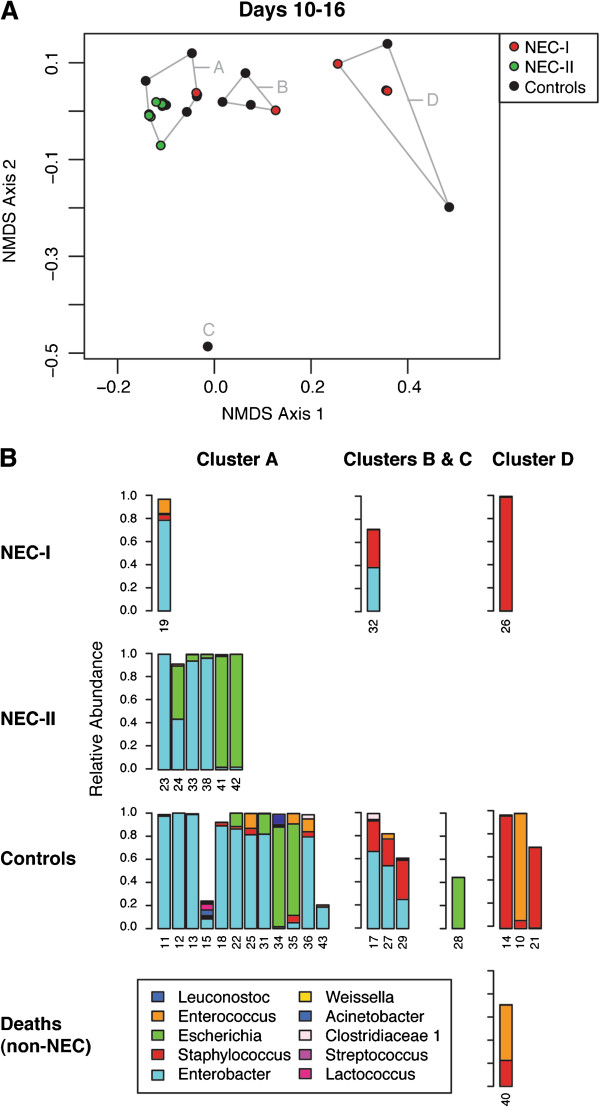
NMDS ordination of microbial communities for days 10 to 16 of life. (A) This ordination was based on weighted UniFrac beta diversity and run with three dimensions in the vegan package of R, resulting in a stress of 2.43. Controls are shown in black and NEC and non-NEC deaths in either red (cases identified as NEC-I in the ordination for days 4 to 9) or green (cases identified as NEC-II in the ordination for days 4 to 9). Clusters identified using the Ward minimum variance method are indicated in this ordination as A, B and D; C is identified as an outlier value. (B) Bars indicate the relative abundance of the ten most common genera in samples from individual infants, whose study numbers are noted on the horizontal axis. NEC sub-types (NEC-I and NEC-II) correspond to the NEC cases included in Cluster I and Cluster II, respectively, in the ordination of samples for days 4 to 9 (Figure 3). The clusters identified in this ordination are indicated by column headers. Clusters indicate microbial community similarity. NEC: necrotizing enterocolitis; NMDS: non-metric dimensional scaling.